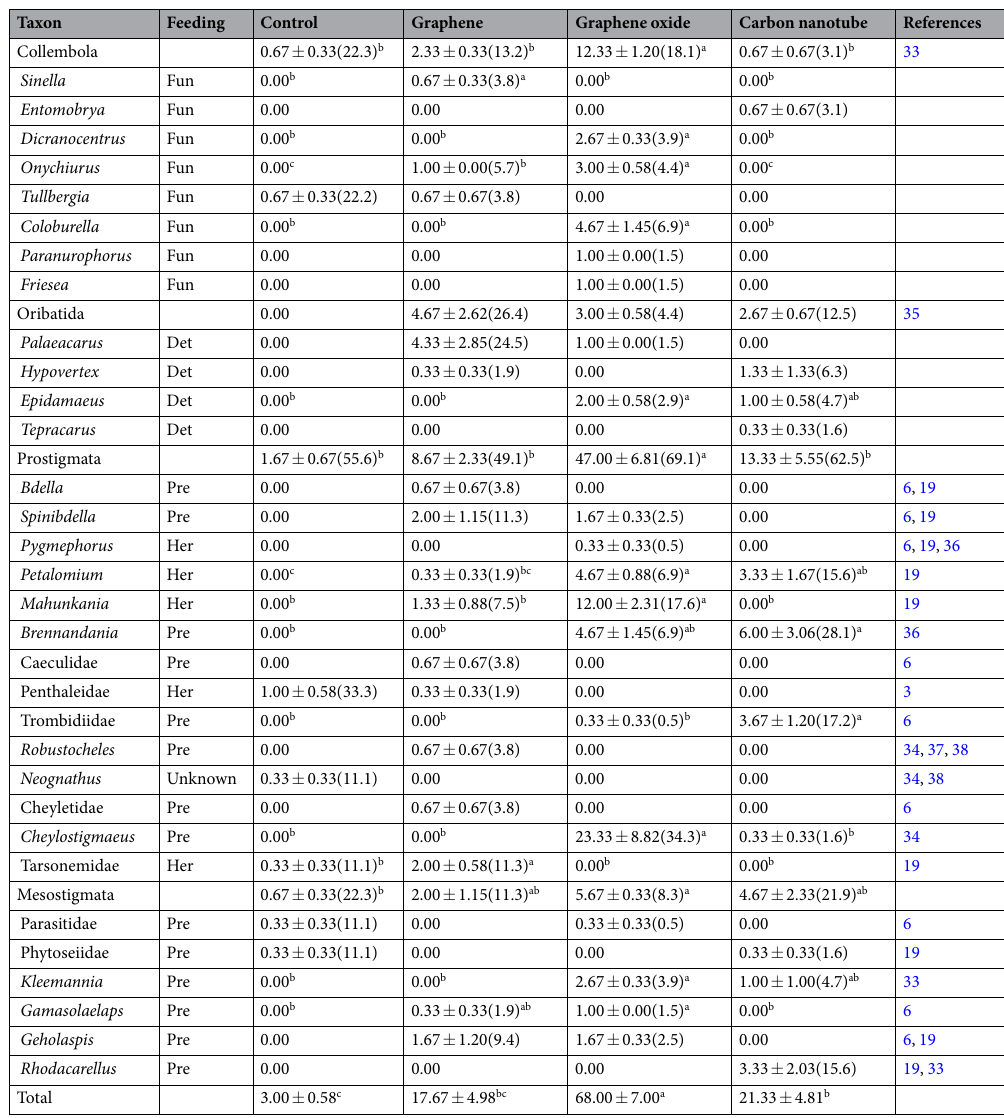
Table 1. Composition of soil microarthropods in the different treatments (relative abundance % given in parentheses). Fun, fungivores; Det, detritivores; Pre, predators; Her, herbivores. Different letters indicate statistically significant differences between treatments, according to the LSD multiple range test ( p <